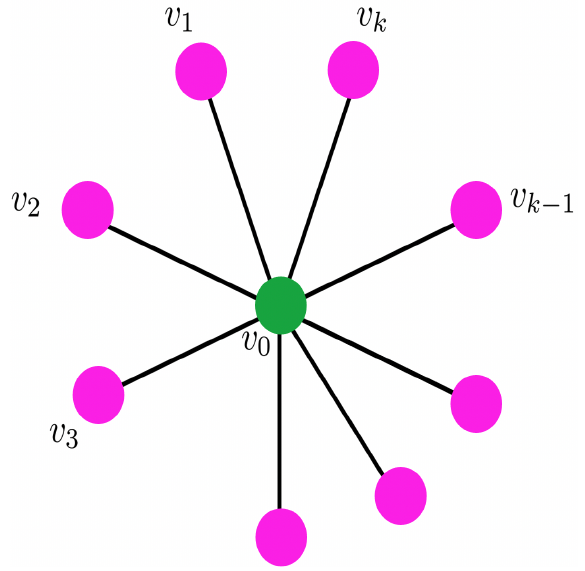
Figure 2. An illustration of the star graph. Neopentane graphs, which are more pliable than star graphs, were used here to broaden this problem by utilizing the notion of neopentane graphs (see Figure 3).